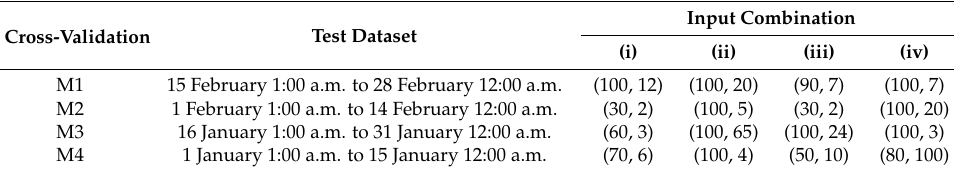
Table 4. Parameters of LSSVR for each input combination for wind speed prediction.